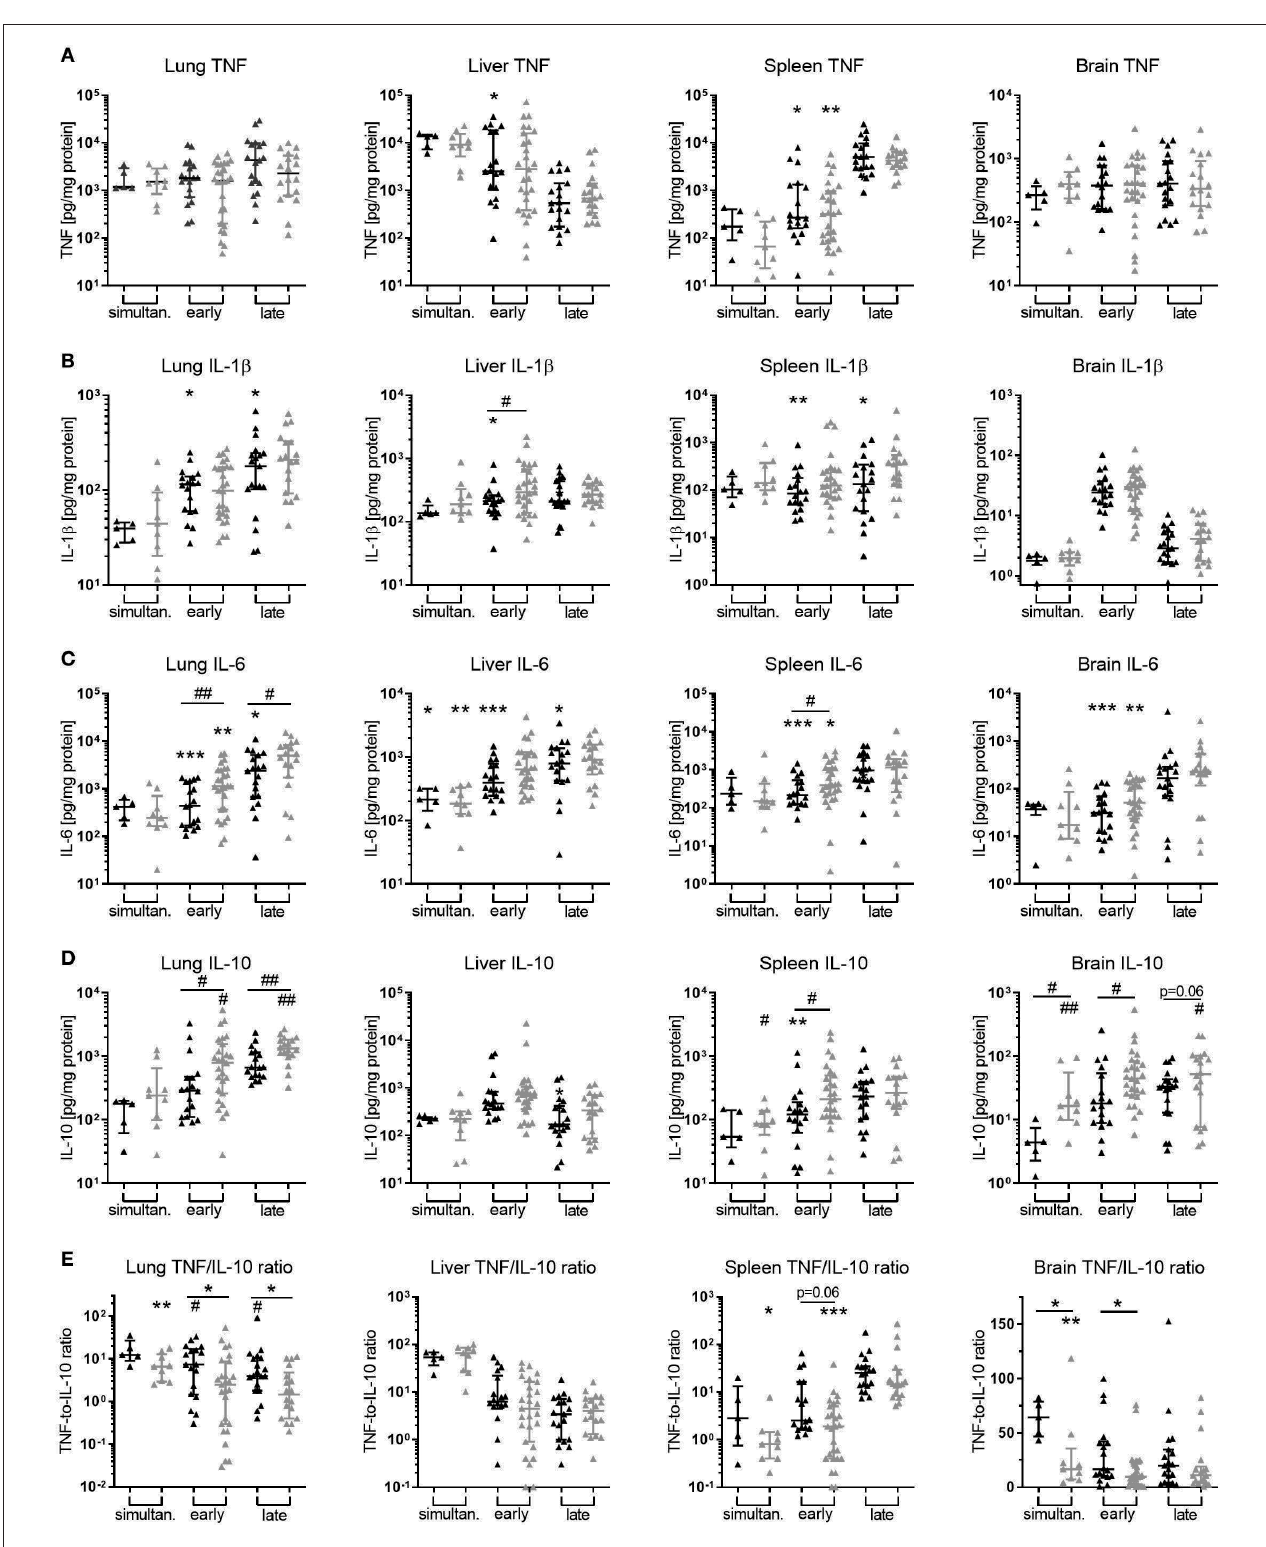
FIGURE 10 | Addition of PTX to GENT enhanced E. coli -induced IL-10 production in peripheral organ tissues. Neonatal mice < 24h old were injected IV with E. coli 10 5 CFU/g body weight, followed by simultaneous (0h, n = 7–9), early (1.5h, n = 18–34), or late (4h, n = 19–20) IP injection of SAL, GENT, or (GENT + PTX). After an additional 4h of incubation, i.e., 4, 5.5, or 8h from the time of sepsis initiation, mice were euthanized and homogenized organ tissue (A) TNF, (B) IL-1 β , (C) IL-6,